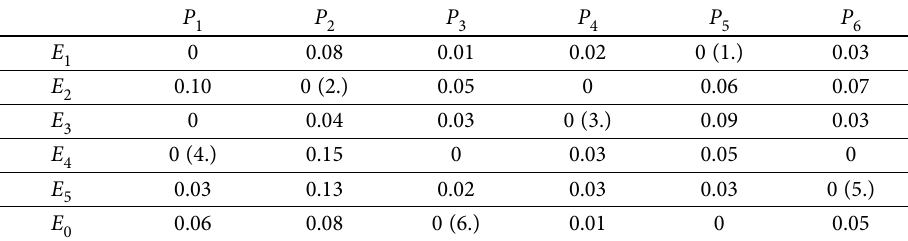
Table 10. Aggregated results with the IOWAD operator (2) P